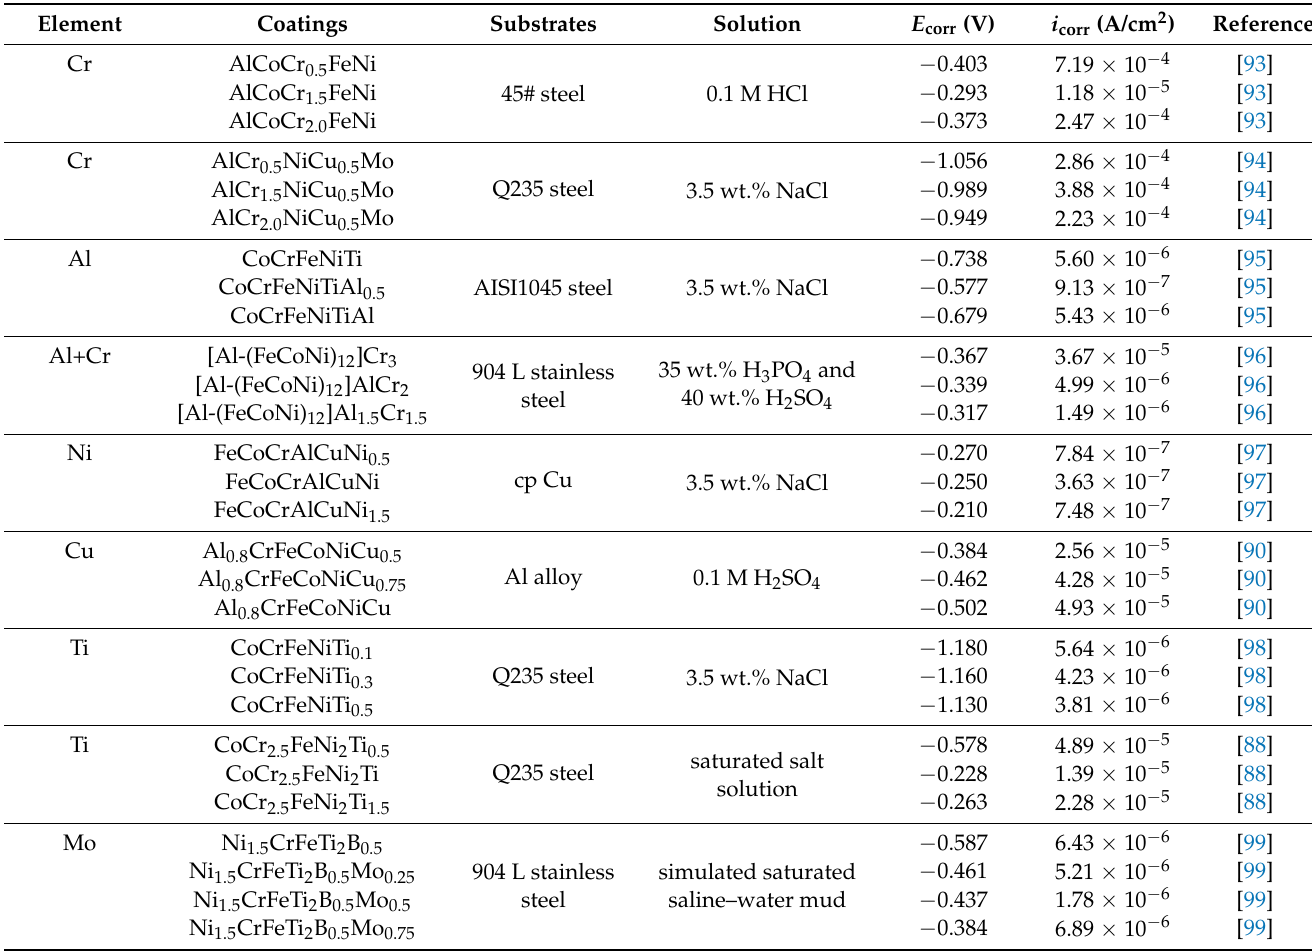
Table 2. Electrochemical corrosion parameters of HEA coatings with different alloy